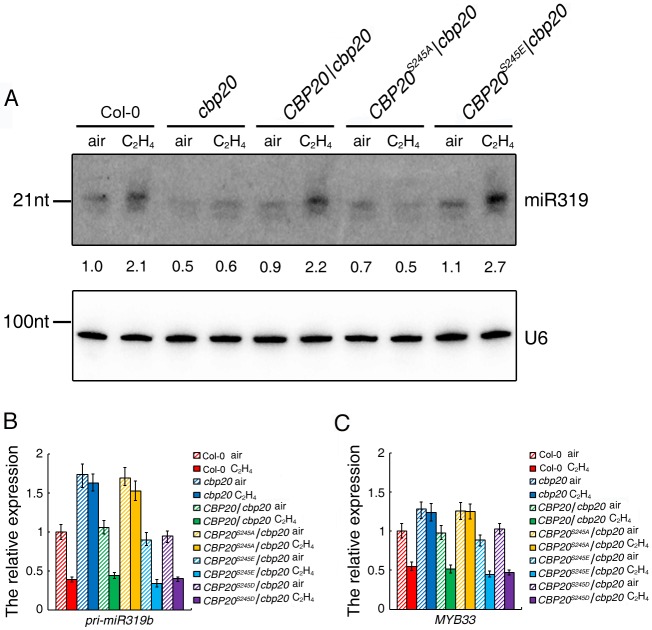
CBP20 phosphorylation regulates miR319 biogenesis and MYB33 expression.(A) Small RNA northern blot of miR319 in roots of 3-day old seedlings of plants indicated in the figure treated with air or 4 hours ethylene gas. Numbers indicate the relative expression level compared with the U6 control. (B) The relative gene expression of pri-miR319b in roots of 3-day old seedlings of plants indicated in the figure treated with air or 4 hours ethylene gas. (C) The relative gene expression level of MYB33 in cbp20 mutant and cbp20 mutant transformed with full length of CBP20, constitutive mimic dephosphorylated of CBP20 (CBP20S245A) and constitutive mimic phosphorylated of CBP20 (CBP20S245E and CBP20S245D) treated with ethylene. Total RNAs were extracted from the roots of 3-day-old etiolated seedlings from indicated genotypes and gene expression was analyzed by qualitative RT-PCR (3 biological replicates).